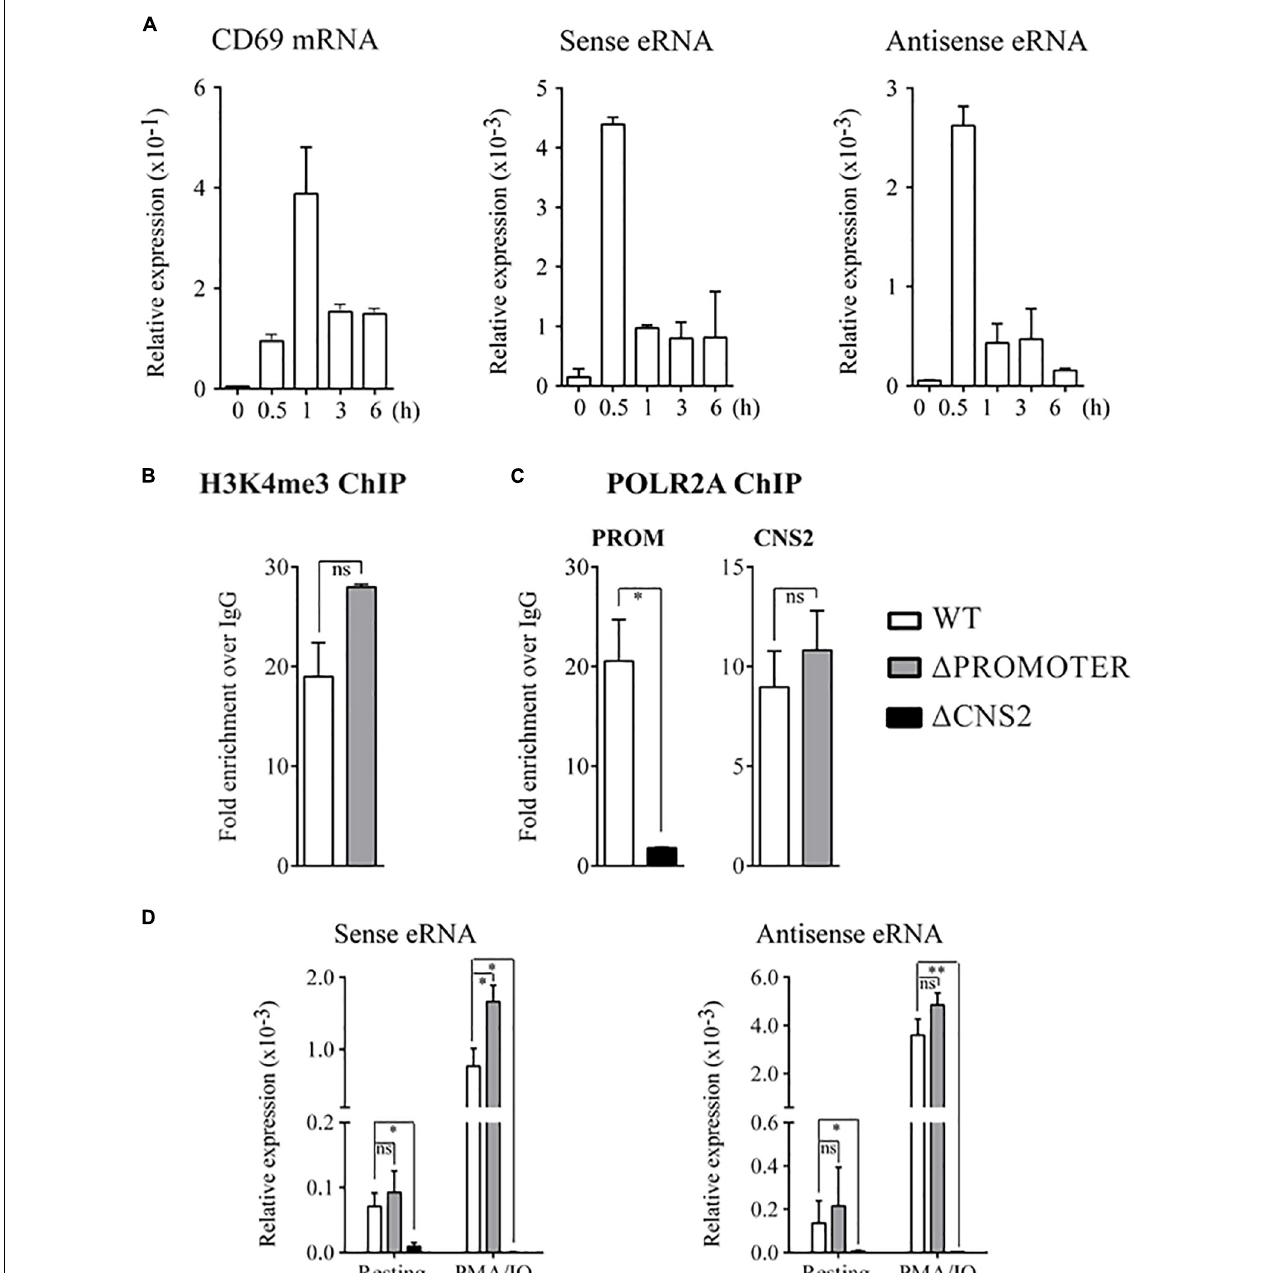
FIGURE 4 | CNS2 eRNA production is independent of the CD69 promoter. (A) CD69 mRNA, sense and anti-sense eRNA kinetics measured in wild type Jurkat T cells after activation were assayed by quantitative PCR. Mean ± SEM of the data of two different experiments is shown. (B) H3K4me3 at CNS2 region in WT and (cid:49) PROMOTER Jurkat T cells after 30 min stimulation with PMA/IO. C POLR2A binding at the CD69 promoter or CNS2 element after 30 min-stimulation assayed by ChIP in Jurkat WT, (cid:49) PROMOTER and (cid:49) CNS2 cells. (B,C) Each analysis was performed with a mix of three different clones for (cid:49) PROMOTER and (cid:49) CNS2 conditions. Error bars denote the mean ± SEM of two different technical duplicates. (D) Quantification of sense and antisense eRNA levels in the basal state and after 30 min-stimulation in WT, (cid:49) PROMOTER, and (cid:49) CNS2 cells. The results of three experiments using different clones are presented as mean ± SEM.ns: non-significant, ∗ p < 0.05, ∗∗ p <